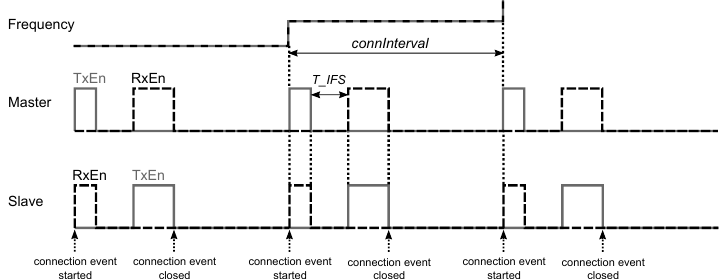
Figure 5. Connection interval—the interval begins and ends with the start of the first data packets from the master using different data channel indices.